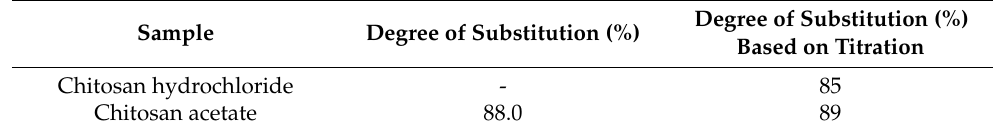
Table 9. Degree of substitution for chitosan salts, calculated based on 1 H-NMR spectra. Sample Degree of Substitution (%)